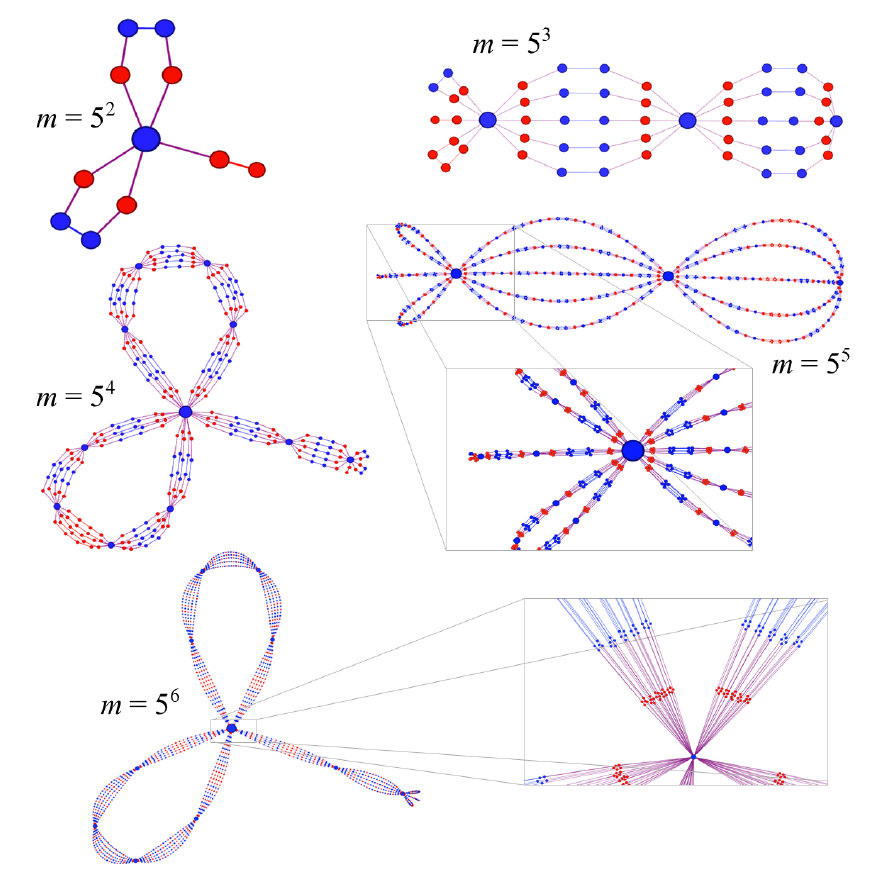
Figure 11. Examples of graphs for prime powers, m = 5 a for a ranging from 2 through 6 are shown. The even powers maintain the general shape of the flower graph. The scaling procedure is described in Section 10. The odd powers maintain the general shape of the linear path for the base prime (again, scaling is described in the text). The vertices are referred to using the ultimate, penultimate, and antepenultimate vernacular. For the case of m = p 4 , there is one ultimate vertex of degree p 2 and each petal has p − 1 penultimate vertices. For the case of m = p 6 , there is one ultimate vertex of degree p 4 , and each petal has p − 1 penultimate vertices; between each penultimate vertices there are p − 1 antepenultimate vertices (too small to see in the figure). The odd powers proceed in a similar manner. The graphs are colored according to whether a vertex represents a perfect square (red) or a nonsquare